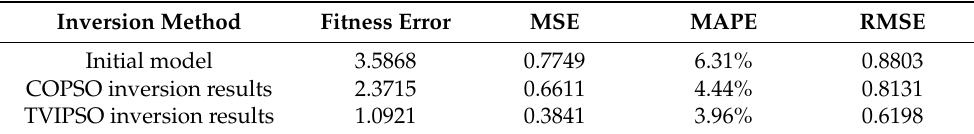
Figure 11. Convergence curves of the fitness functions for COPSO inversion and TVIPSO inversion algorithms. Table 3. Comparison of iteration details for the two PSO algorithms.